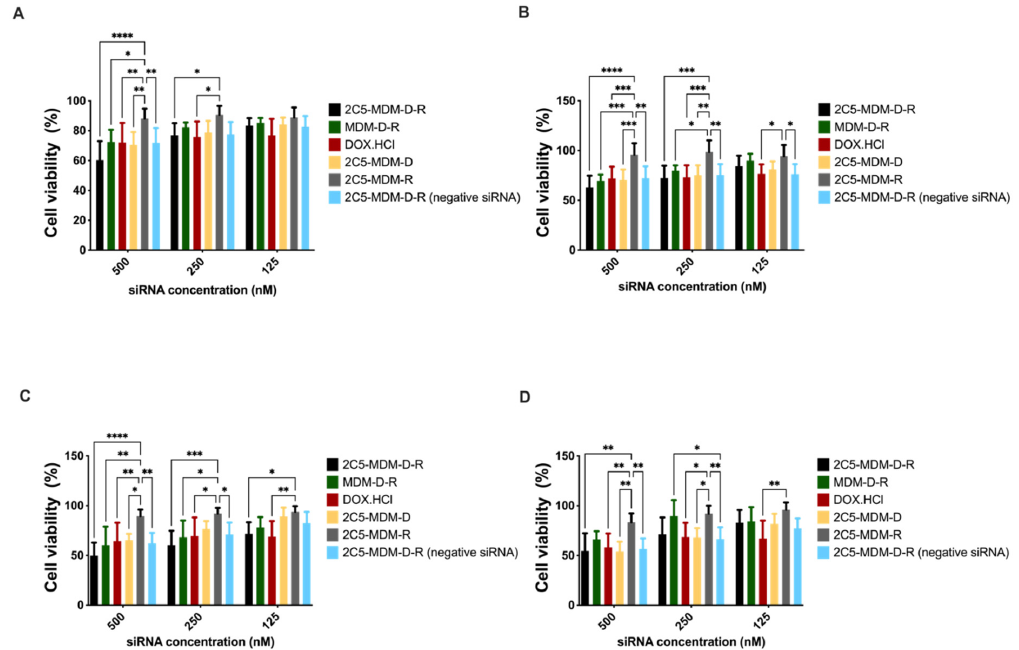
Figure 6. Cell titer blue (CTB) assay of 2D monolayer cytotoxicity study of MDA-MB-231, ( A ): 1 h of treatment and 23 h of recovery, ( B ): 2 h treatment and 22 h of recovery, ( C ): 1 h treatment and 47 h of recovery, ( D ): 2 h treatment and 46 h of recovery. Results indicate ± SD ( n = 3), and significance was calculated with two-way ANOVA comparisons. **** p ≤ 0.0001, *** p ≤ 0.001, ** p ≤ 0.01, * p ≤ 0.05.